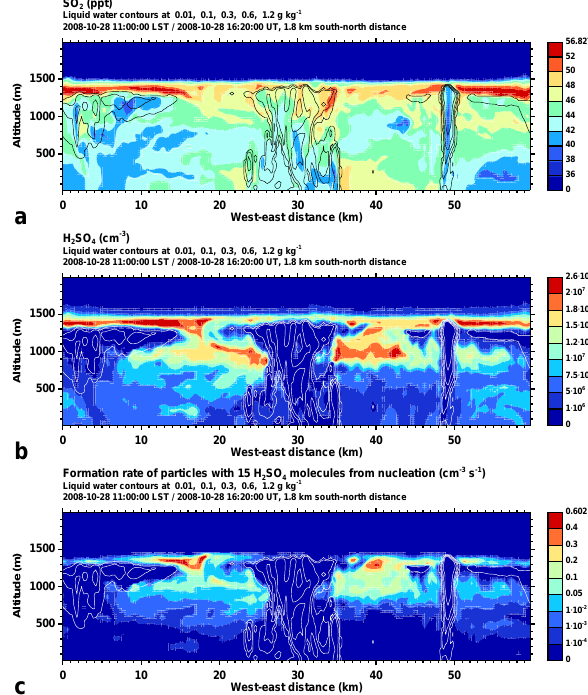
Fig. 4. Vertical slices through the domain of simulation S 0 at 28 October 2008 16:20UT. Contour lines denote liquid water (sum of cloud and rain water). (a) Cloud processes in open cell updrafts de- plete aerosol particles and reduce the aerosol H 2 SO 4 condensation sink, which is lowest inside clouds. The clean, cloud-processed air detrains in the upper boundary layer and forms an ultra-clean layer with low aerosol H 2 SO 4 condensation sink values. (b) Updrafts lift DMS emitted from the ocean into the upper boundary layer. (c) Scattering of solar radiation around cloud tops results in elevated OH concentrations, which oxidize DMS to SO 2 .